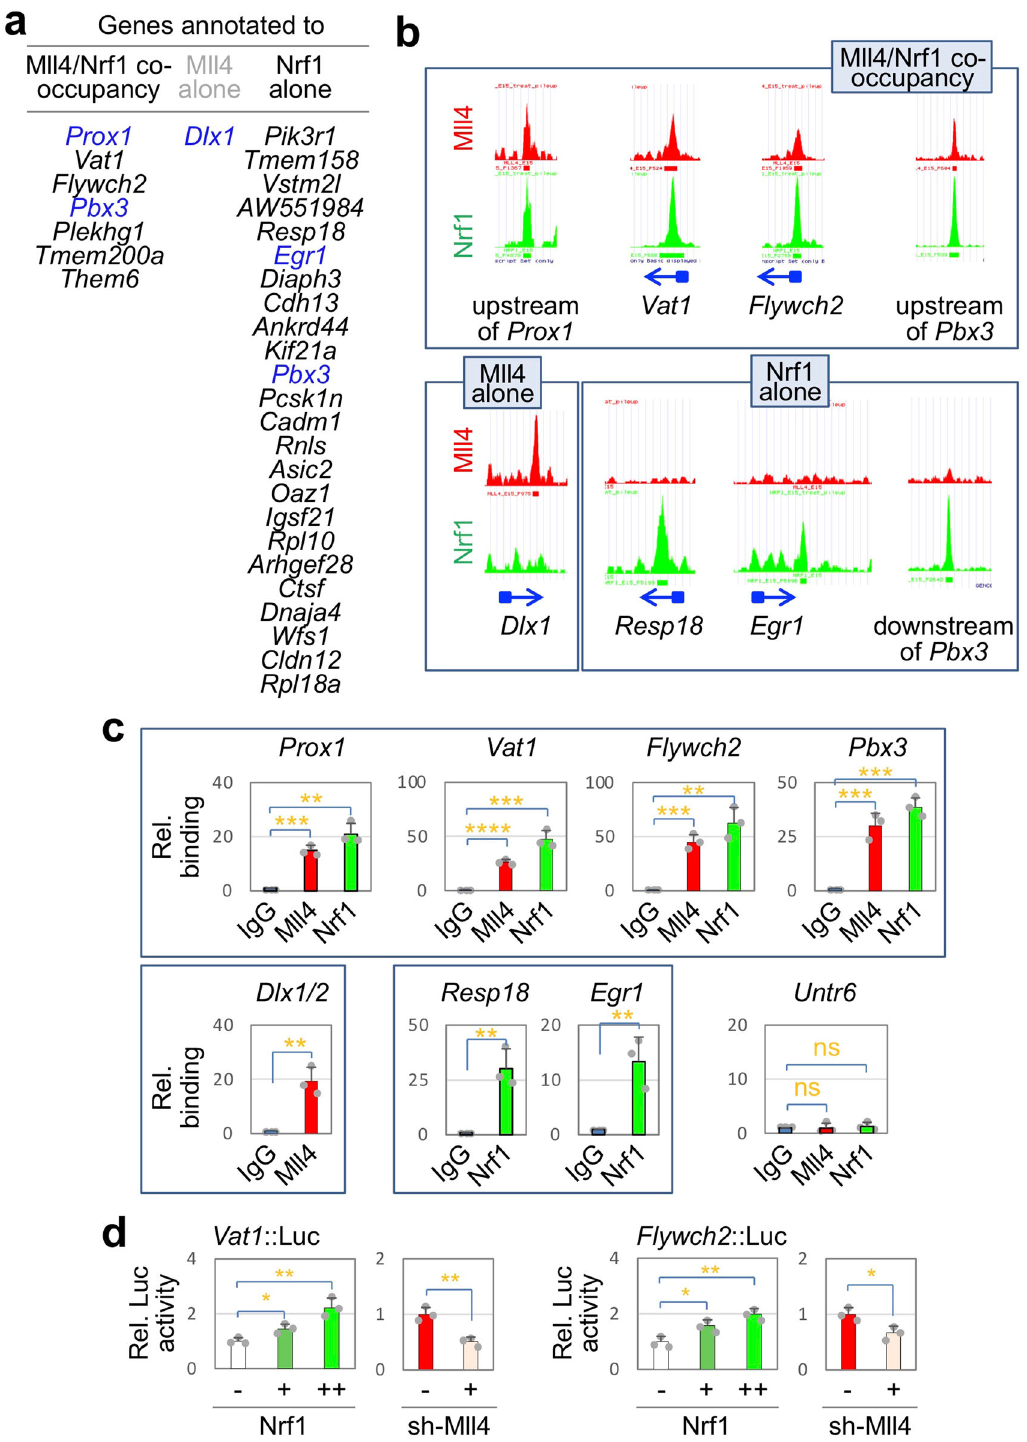
Fig. 5 Target genes of Mll4 in developing mouse GHRH neurons. a List of genes in developing mouse GHRH-neurons, which are associated with either Mll4 or Nrf1 ChIP-seq peaks or both Mll4 and Nrf1 ChIP-seq peaks. Genes encoding transcription factors are highlighted in blue. b Mll4 and Nrf1 ChIP-seq peaks for representative target genes of Mll4 in developing GHRH-neurons. The location of each peak with regard to its associated gene is marked by an arrow for the direction of the gene and a square for the 5 ′ UTR (both in blue). c Independent validation ChIP experiments with E15 hypothalamus and IgG (controls) and antibodies against Mll4 and Nrf1 reveal recruitment of Mll4 and Nrf1 to representative target genes of Mll4. Column bars represent mean of experiments with three independent embryos, error bars indicate the SD. d Luciferase reporter assays reveal that the common ChIP-seq peak areas for Mll4 and Nrf1 in Vat1 and Flywch2 are responsive to ectopic expression of Nrf1 and shRNA against Mll4. Column bars represent mean of three independent experiments, error bars indicate the SEM. Statistical differences were determined by two-sided Student ’ s t -test; not signi fi cant (ns), * p < 0.05, ** p < 0.01, *** p < 0.001, and **** p < 0.0001.